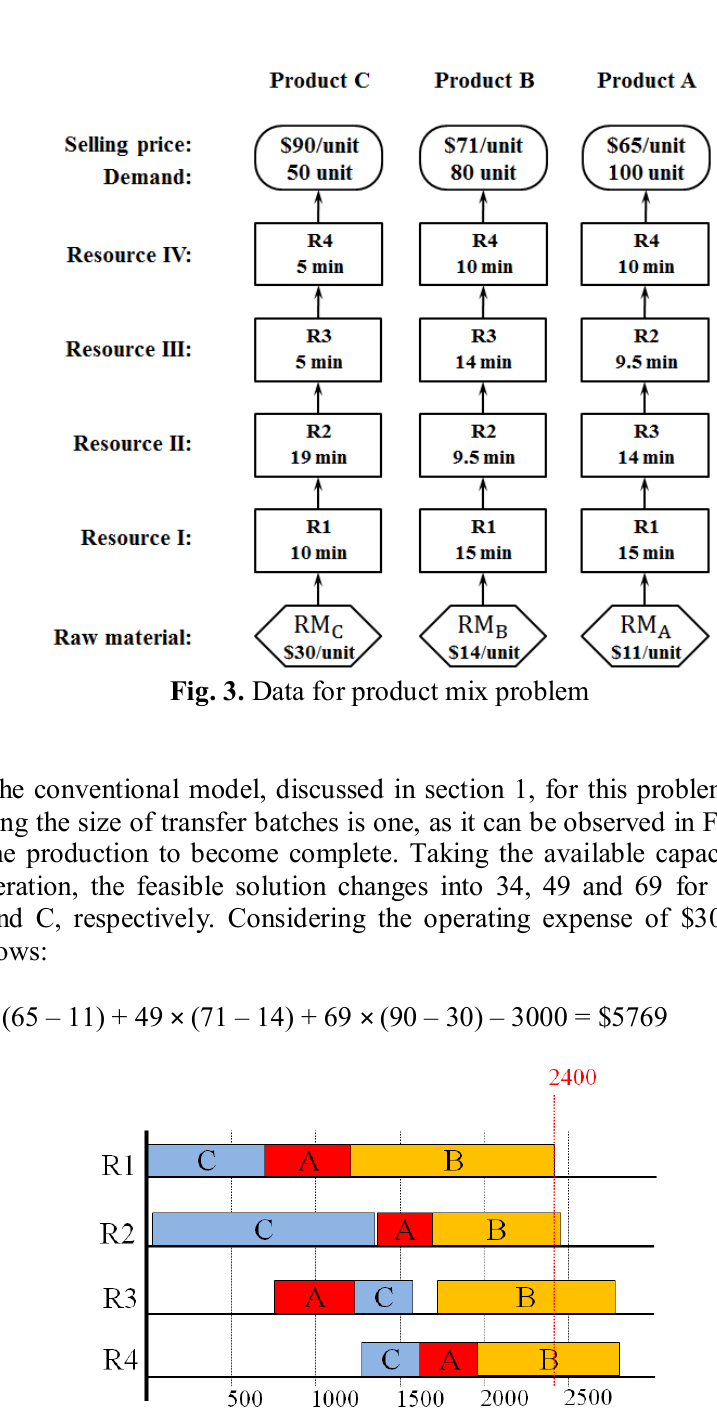
Fig. 4. Gantt chart for the conventional model solution (34A, 80B and